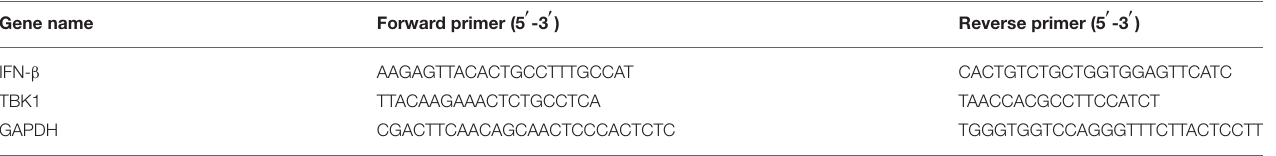
TABLE 1 | Primers used for Quantitative Real-Time